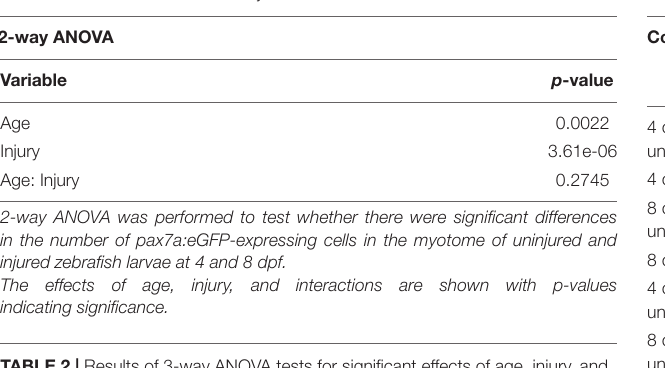
TABLE 2 | Results of 3-way ANOVA tests for significant effects of age, injury, and DAPT on muSC number. 3-way ANOVA Variable